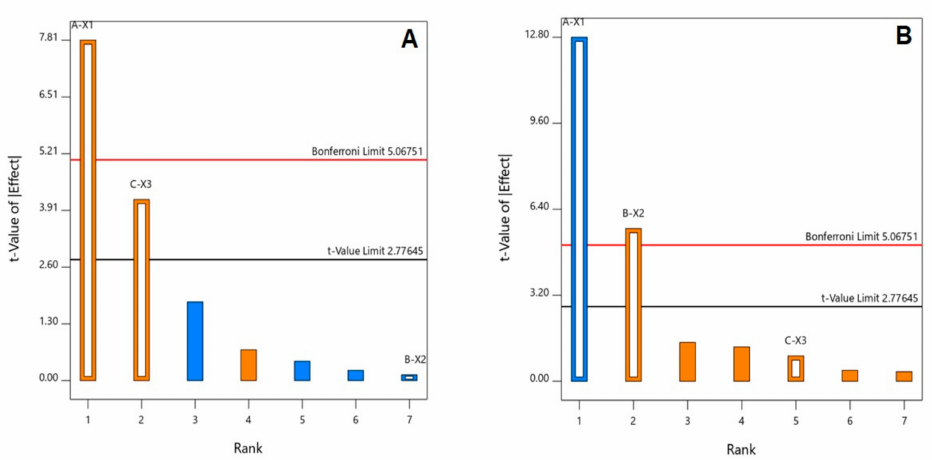
Figure 2. Standardized Pareto chart for the ( A ) entrapment e ffi ciency % and ( B ) cumulative percent EA released of EA–Ca pectinate floating beads.